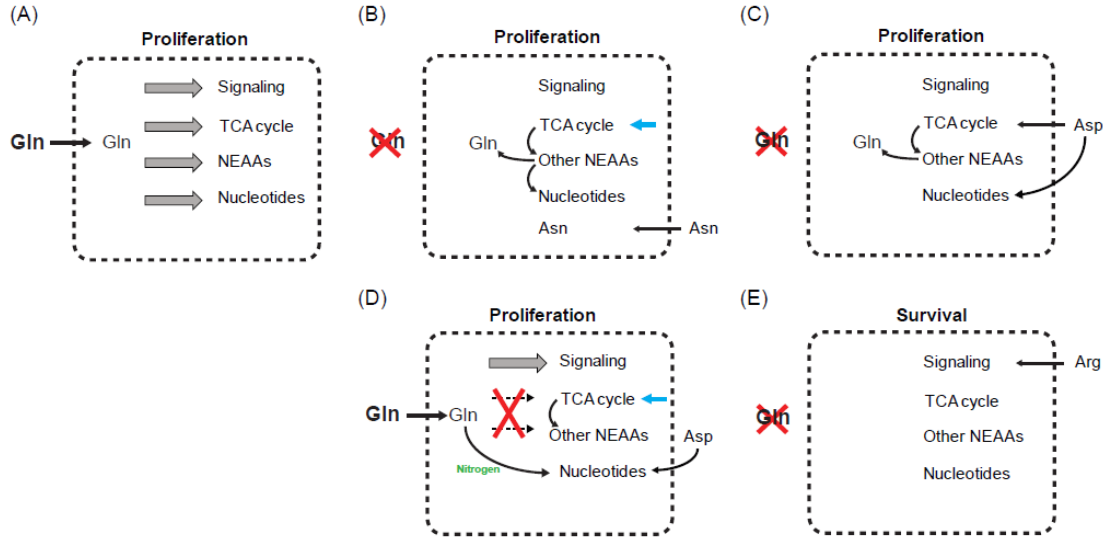
Figure 2. Possible paradigms of defining the critical limiting metabolite. ( A ) In glutamine-replete condition, glutamine is used for many biosynthetic and non-biosynthetic purposes (grey boxed arrow), which together contribute to tumor cell proliferation. For simplification, we listed signaling, TCA cycle, NEAAs and nucleotides as key components mediating glutamine-dependent cell proliferation. In addition, continuation of some components may rely on the other components as we discussed. ( B ) Following glutamine deprivation, all the glutamine-dependent signaling, TCA cycle